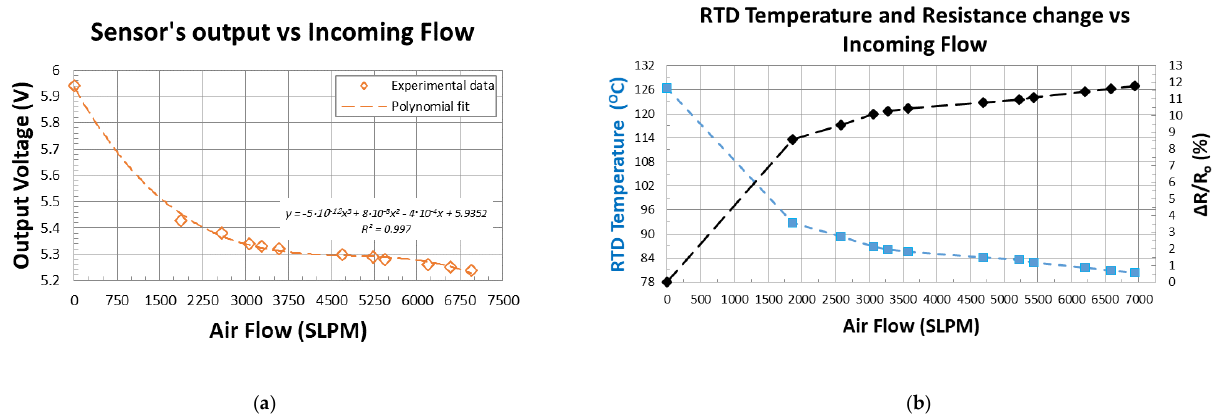
Figure 13. RTD on Low Velocity Bypass. ( a ) Sensor’s output vs. incoming flow; ( b ) RTD temperature and resistance change